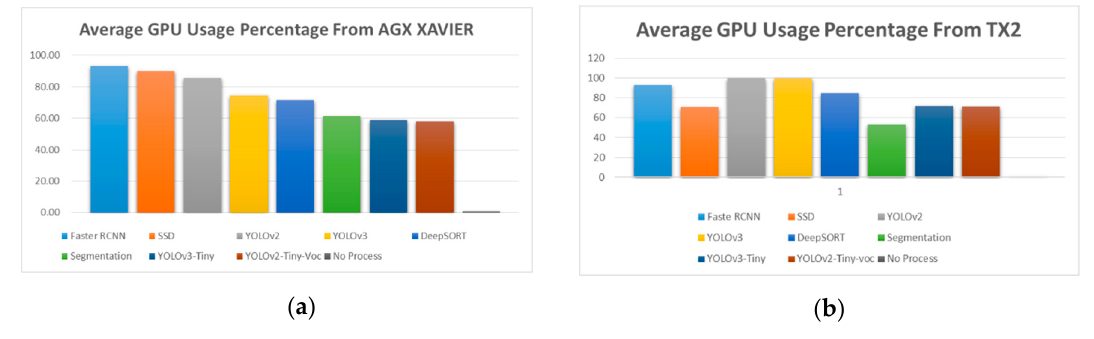
Figure 17. Average GPU usage percentage from ( a ) Xavier and ( b ) TX2.